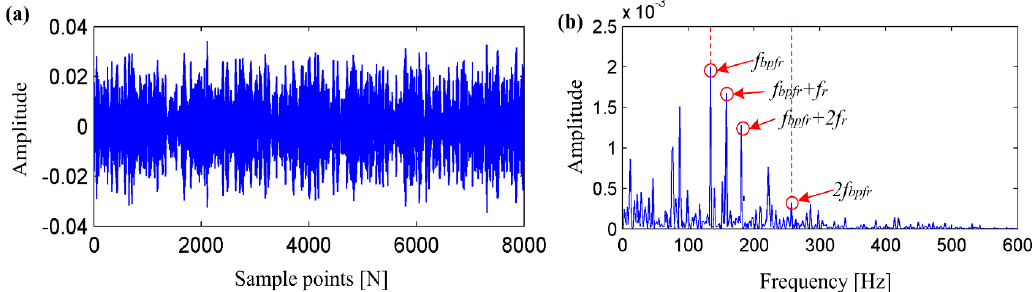
Figure 15. ( a ) The extracted fault feature signal and the ( b ) Teager energy operator spectrum of ball fault 1.